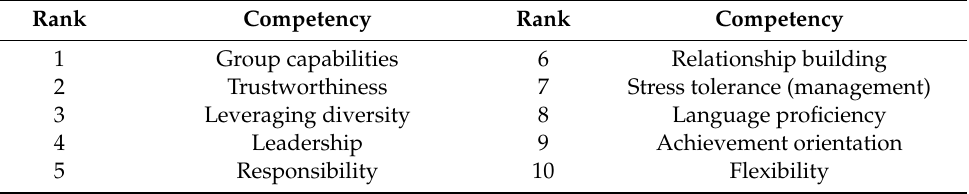
Table 5. The 10 highest significant competencies based on the project managers’ behaviors in their current state.